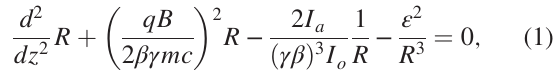
ffiffiffiffiffiffiffiffiffiffiffiffiffi p 1 − β 2